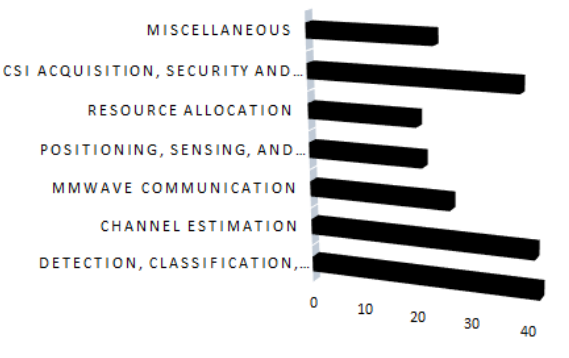
Figure 4. Number of papers surveyed by